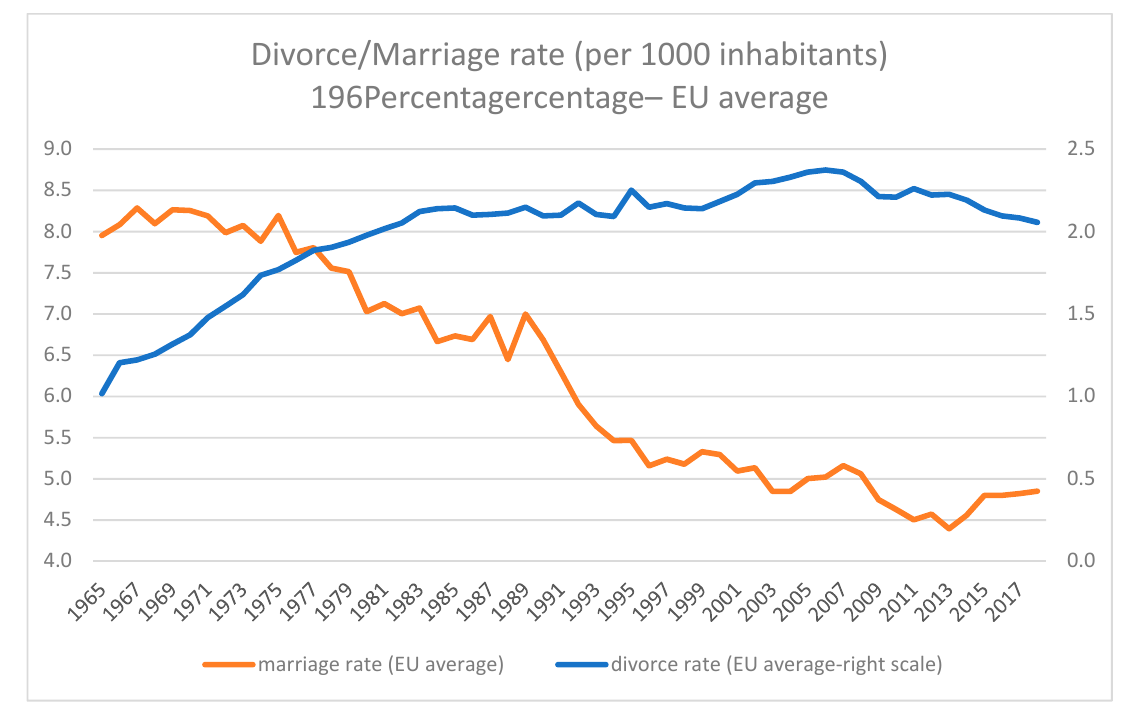
Figure 1. Source: our elaboration on Eurostat data Countries: Austria, Belgium, Bulgaria, Cyprus, Czech Republic, Denmark, Estonia, Finland, France, Germany, Greece, Hungary, Latvia, Lithuania, Luxembourg, Netherlands, Norway, Poland, Portugal, Slovak Republic, Slovenia, Sweden, United Kingdom.